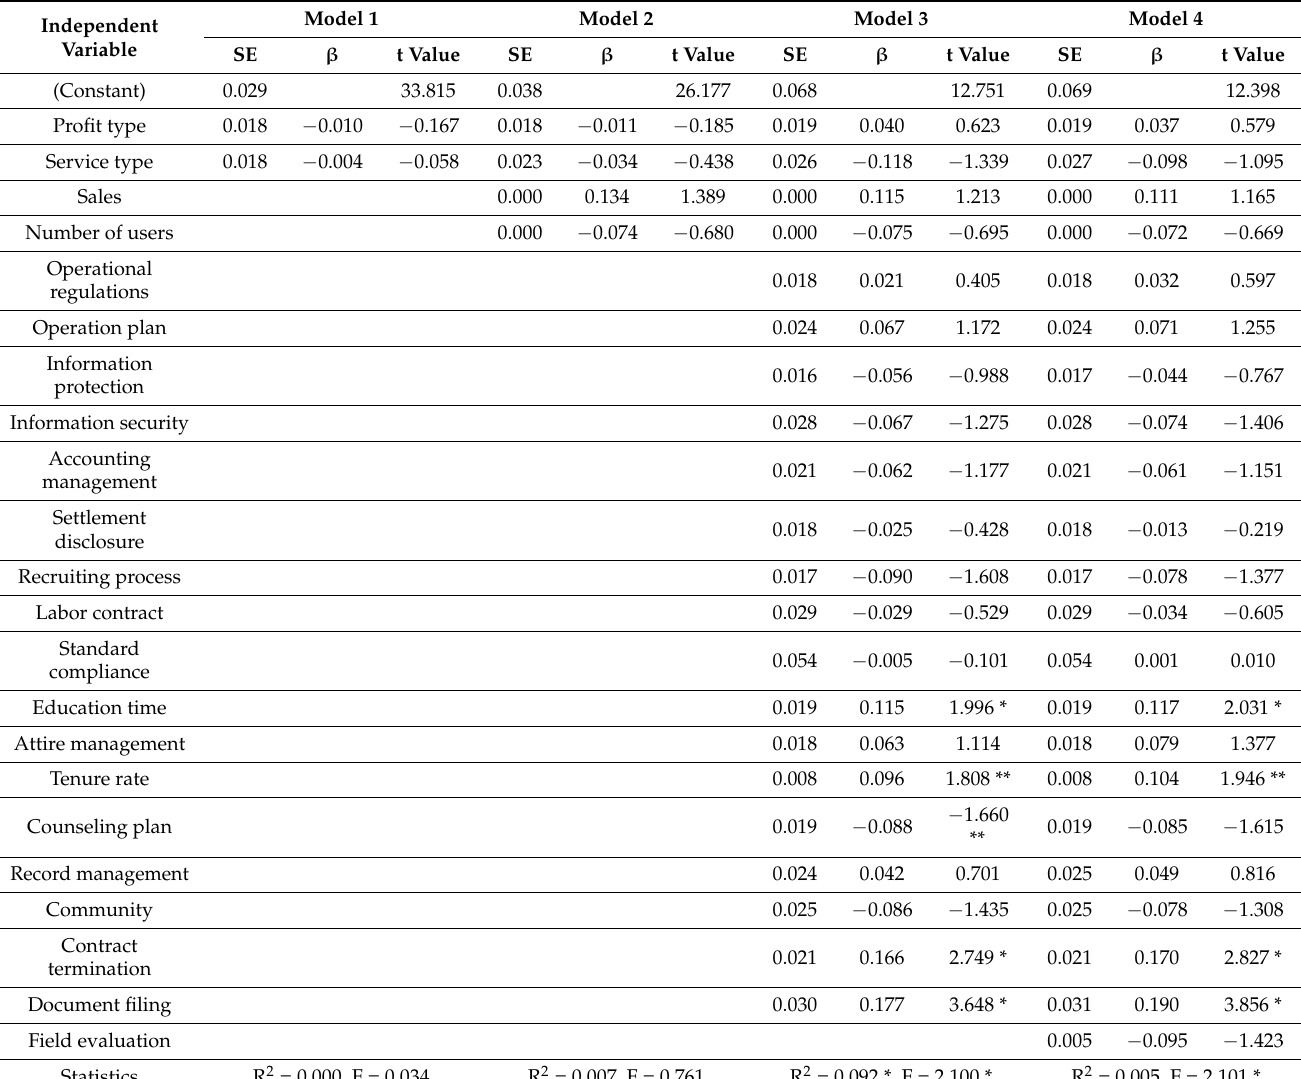
Table 4. Regression analysis for 2013. ( n =